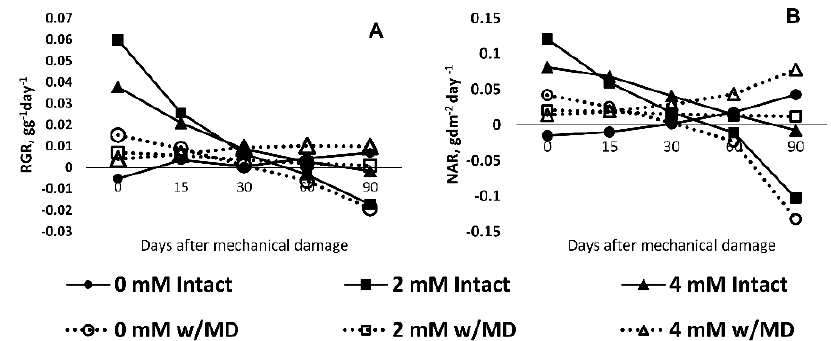
Figure 7. ( A ) Relative growth rate (RGR); ( B ) Net assimilatory rate (NAR) in Annona emarginata plants submitted to the treatments: 0 mM Ca 2+ without mechanical damage (intact), 0 mM Ca 2+ with mechanical damage (w/MD), 2 mM Ca 2+ intact, 2 mM Ca 2+ w/MD, 4 mM Ca 2+ intact, and 4 mM Ca 2+ w/MD, at evaluation times: 0 (30 min) 15, 30, 60, and 90 days. Values correspond to means ± SE ( n =